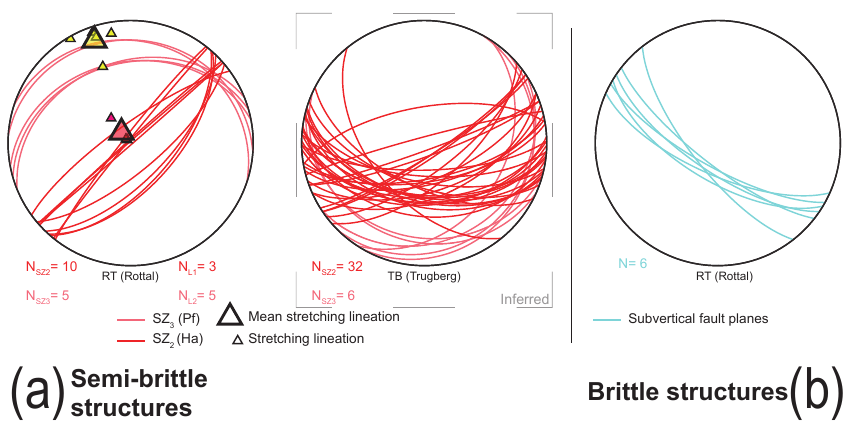
Figure 6. Structural field data for the basement from the Rottal (RT) and Trugberg (TB). (a) Shear zones related to main phases of exhuma- tion. Shear zone orientations for TB were inferred by plane fitting through the moment of inertia of remote-sensed lineaments (data provided in the Supplement folder S1). (b) Vertical lineaments that cross-cut structures as shown in panel (a) . For geographical abbreviations and shear zone legend, see Fig.